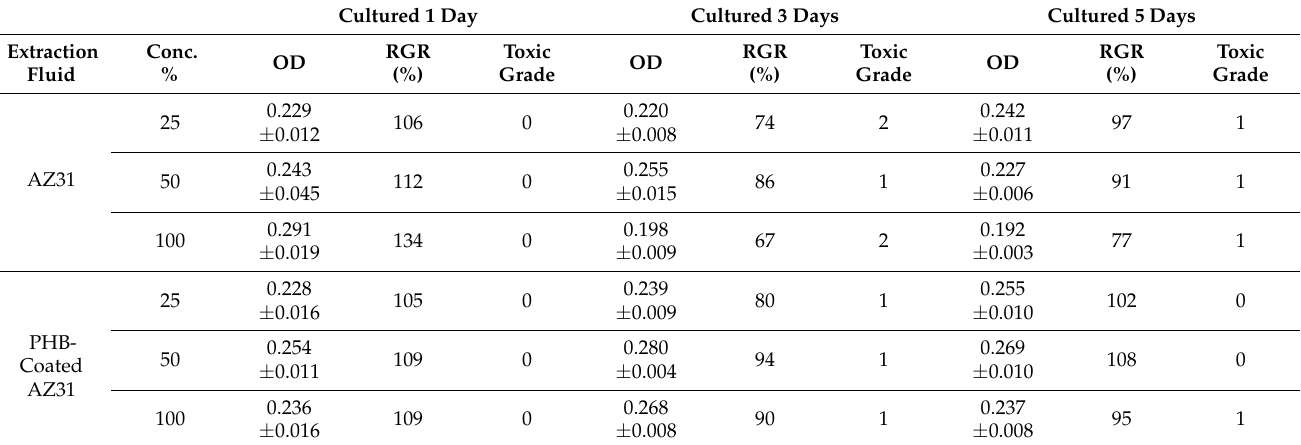
Table 3. Cytotoxicity (CCK-8 assay) test details.